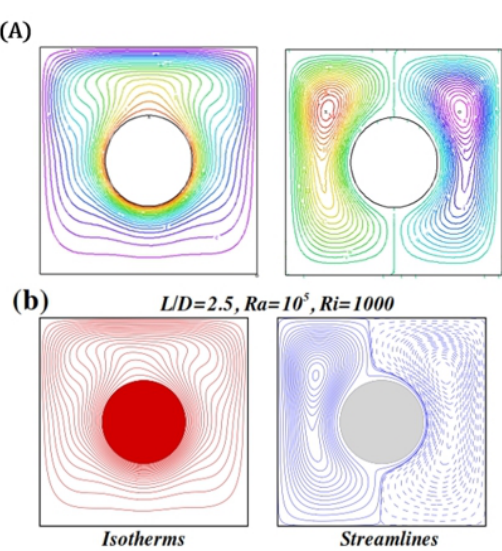
Fig. 3. Comparisons of present study for isotherms and streamlines for mixed convection in domains with rotating and stationary cylinders; a) present study; b) at L/D = 2.5,Ra = 10 5 ,Ri = 1000 [8]